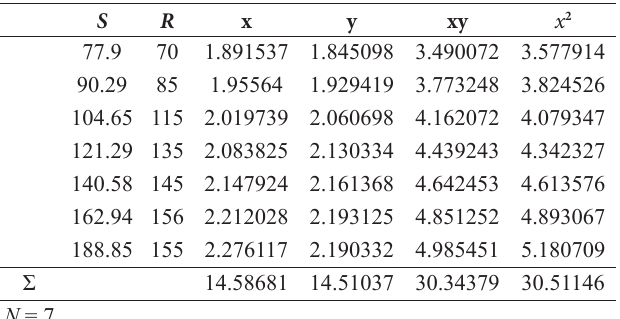
Table 5. Example of an experimental trial with seven distorted images with respective values, S (%), and a participant’s magnitude estima- tion response, R (%). Each magnitude set (S and R) was converted into log, x (log S ), and y (log R ). i i i i